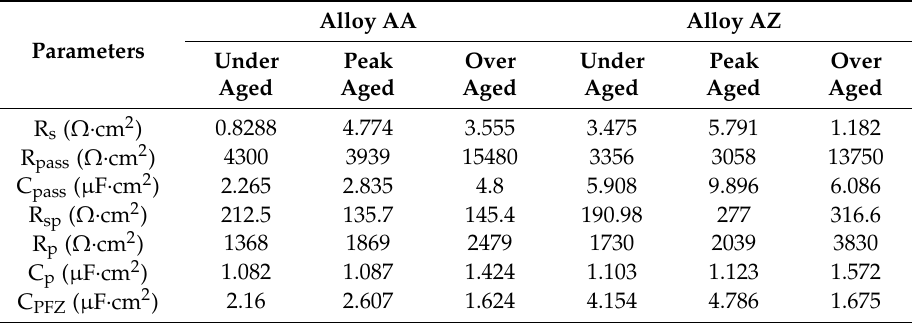
Table 7. Parameters of EIS